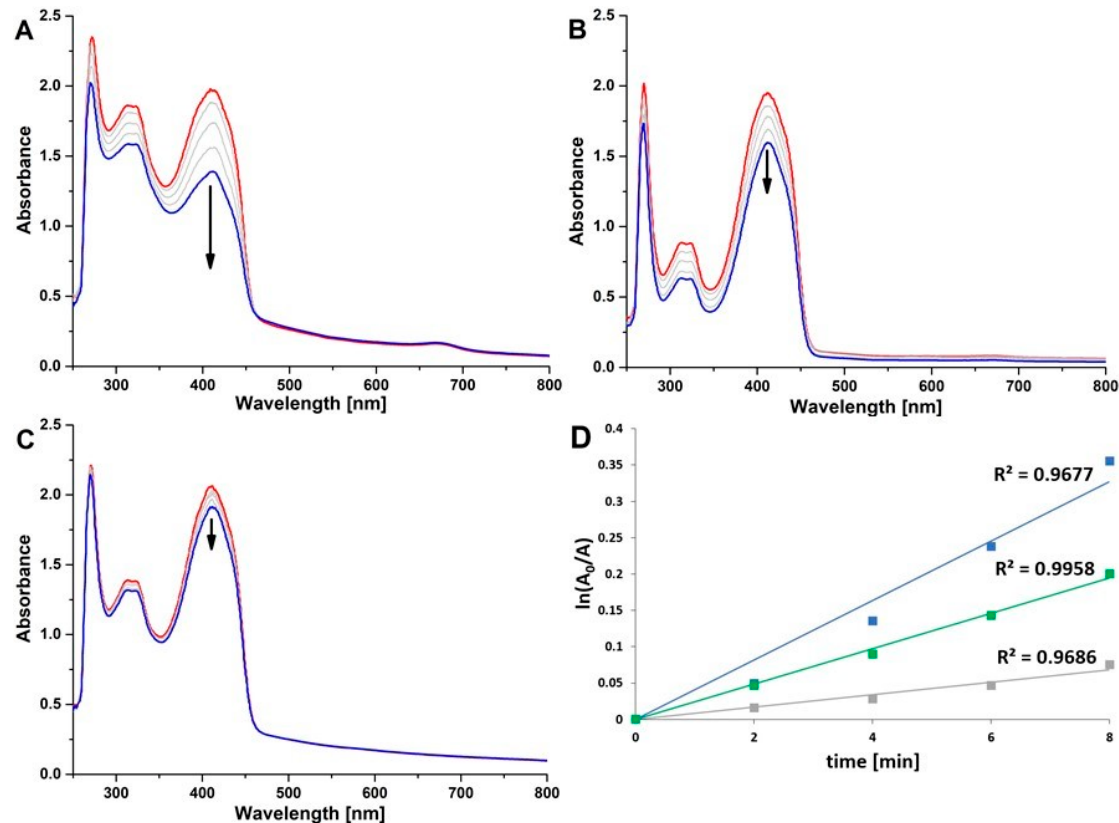
Figure 5. The UV–Vis spectra for the oxidation of DPBF in dimethylformamide in the presence of 4 @P25 ( A ), 5 @P25 ( B ), and P25 ( C ) as catalysts over a period of time. ( D ) the plots of DPBF absorbance in time in the presence of 4 @P25 (blue), 5 @P25 (green), and P25 (grey); DPBF—1,3-diphenyl- isobenzofurane.